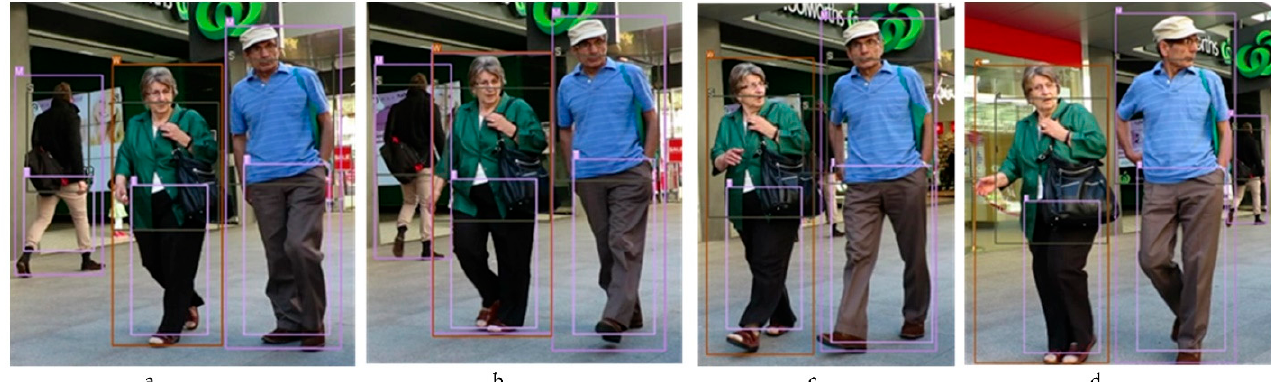
Figure 7. Four images taken from our detection outputs to demonstrate the occlusion phases. The original image is taken from the MOTChalleng dataset [28]. Before occlusion state ( a ), in occlusion state ( b , c ), and after occlusion state ( d ).